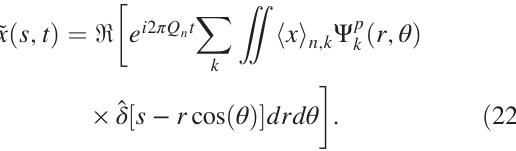
0 (b) Δ Q 20 =Q =Q s ¼ s ¼ SC SC